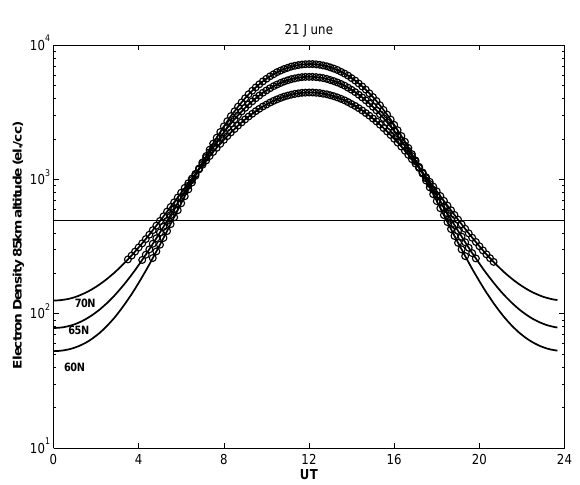
Fig. 12. Estimated electron density at 85km at the summer solstice (21 June) as a function of universal time at 60, 65, 70N and at zero longitude. Below the horizontal line at 500el/cc we expect feasible VLF detection of electron density